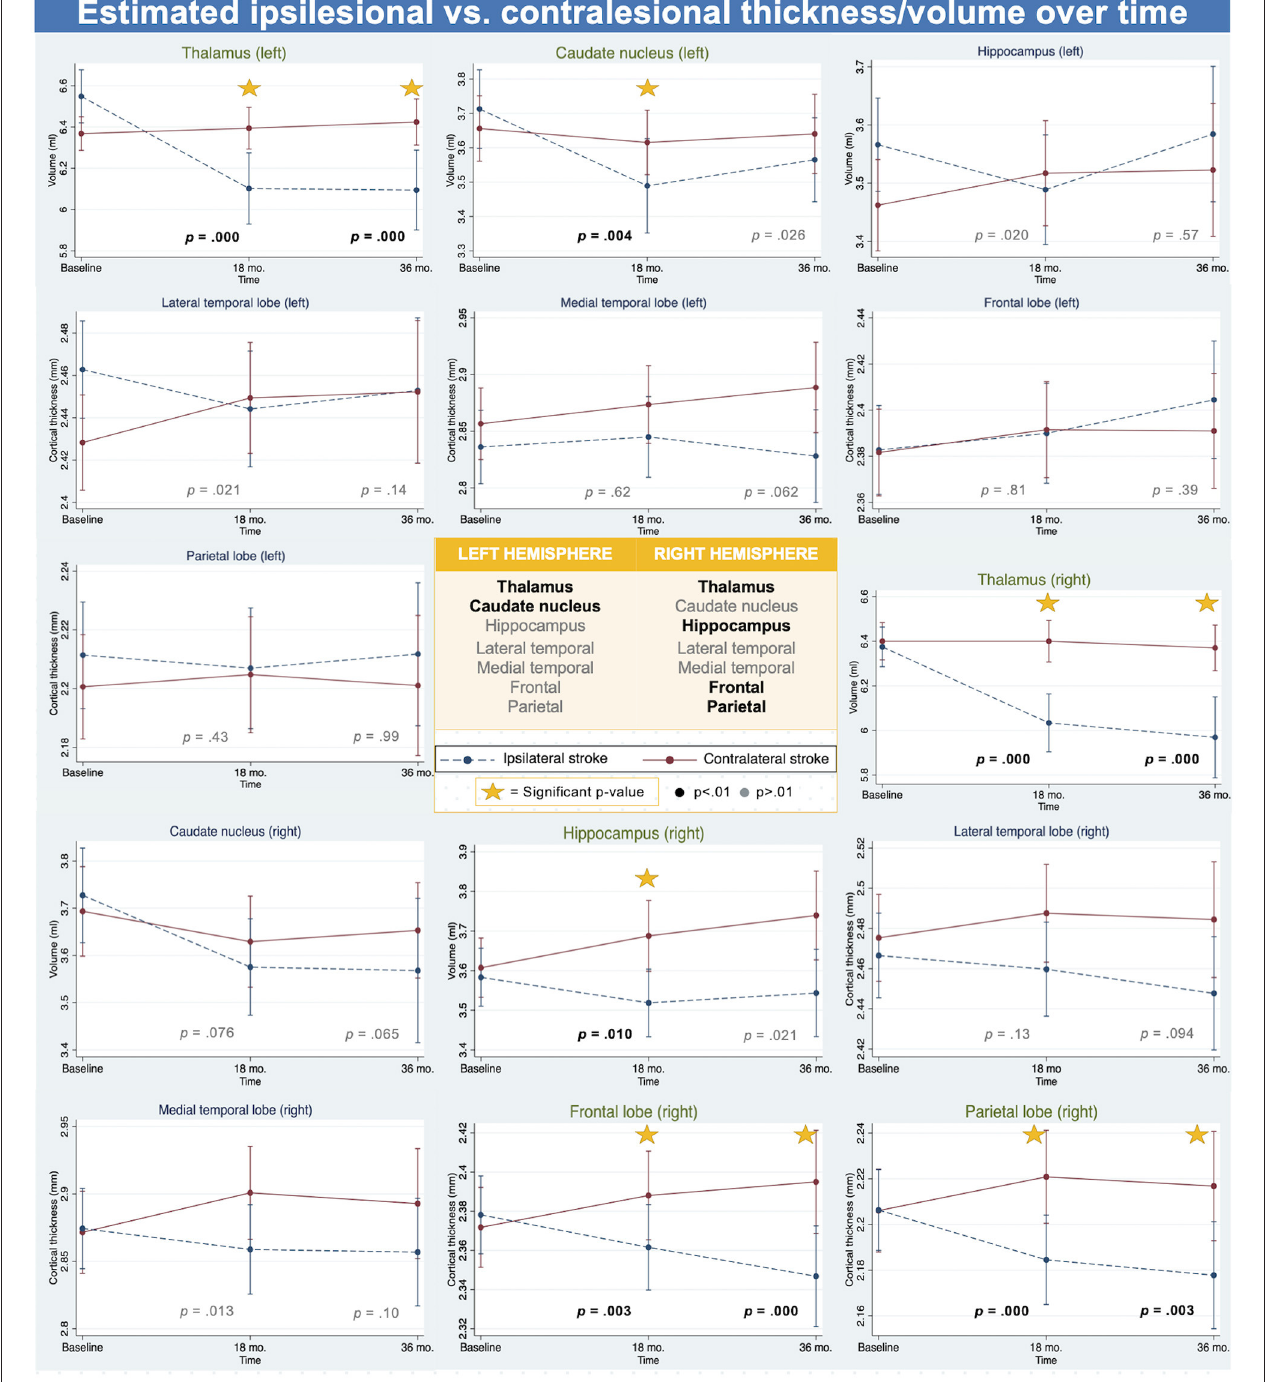
FIGURE 2 | Brain atrophy by stroke hemisphere - analysis I. Figure depicting thickness and volume change over time in ipsilesional vs. contralesional hemisphere in left and right hemisphere, showing the effect was more prominent in right hemisphere areas than in the left hemisphere areas. Significant p- value showed in black and bold at time of result. P- values are for the differences in change from baseline to 18 or 36 months (interaction terms). Significant p- value are in black and bold. Triangle next to p- value indicates significant three-way interaction, indicating a difference between the hemispheres in the effect of contra vs. ipsilesional stroke at timepoint.